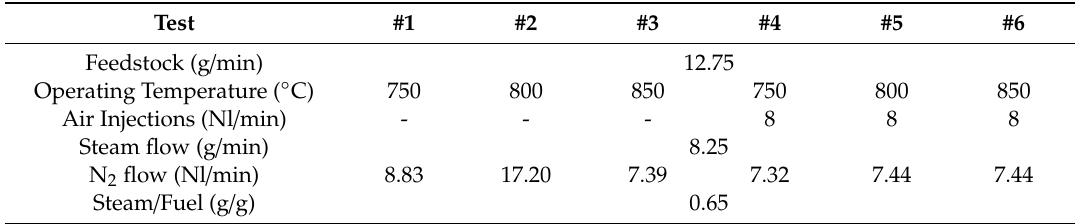
Table 1. Operating conditions of the test campaign .